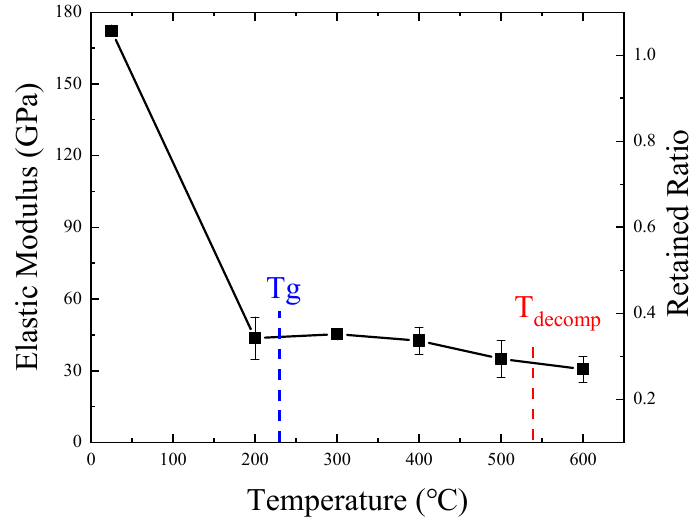
Figure 7. Variety curve of elastic modulus with temperature.